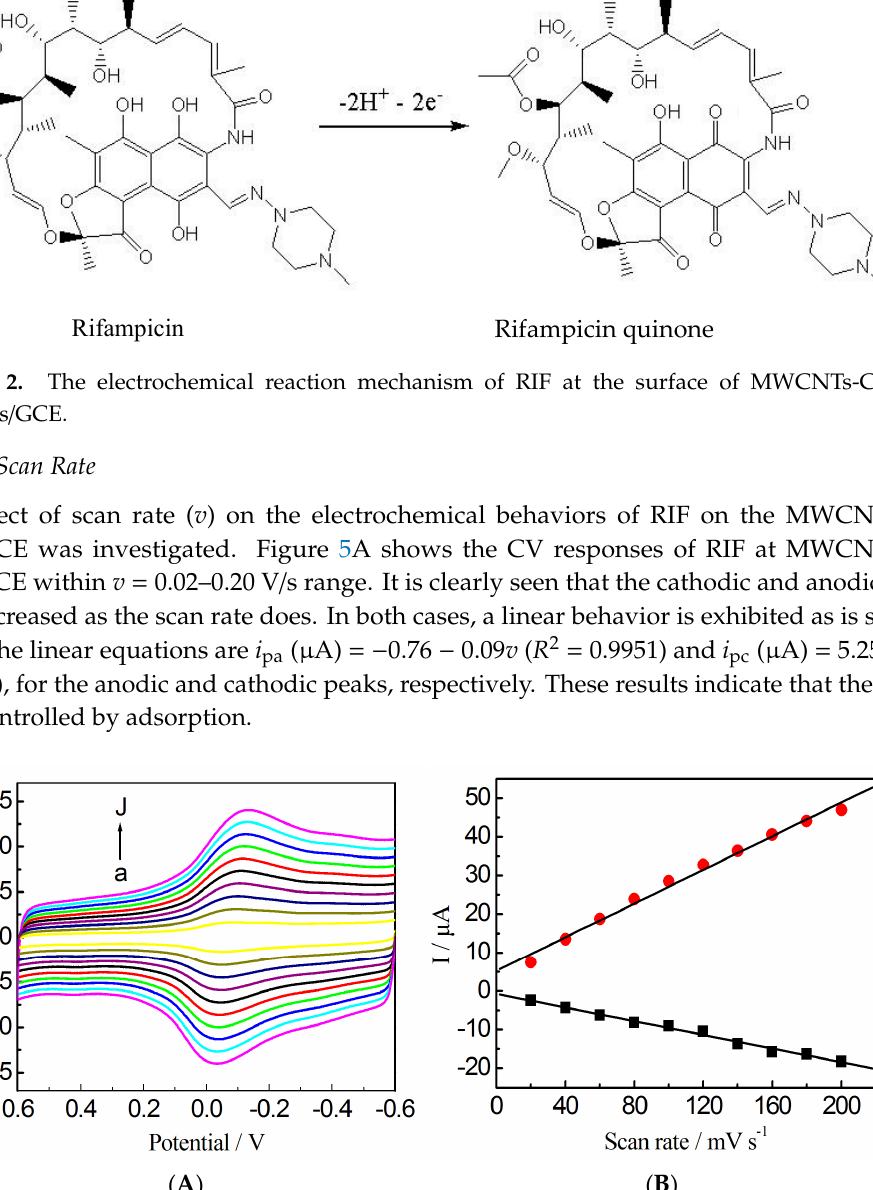
( B ) Figure 6. ( A ) DPVs of the different concentrations of RIF at MWCNTs-CeO 2 nanorods/GCE in 0.1 mol/L PBS (pH = 7.0); ( B ) The reduction peak current vs. the concentration of RIF. a—1.0 × 10 − 13 , b— 1.0 × 10 − 12 , c—1.0 × 10 − 11 , d—1.0 × 10 − 10 , e—1.0 × 10 − 9 , f—1.0 × 10 − 8 , g—1.0 × 10 − 7 , h—1.0 × 10 − 6 mol/L.